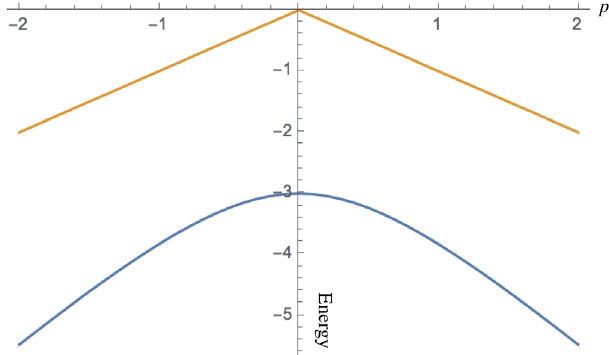
FIG. 2. The exact many-body spectrum (including the ground state and the first excited state) of the Hamiltonian Eq. (4) with the interaction chosen to be Eq. (5). The ground state is non- degenerate and is separated from the excited states by a finite energy gap for all values of p